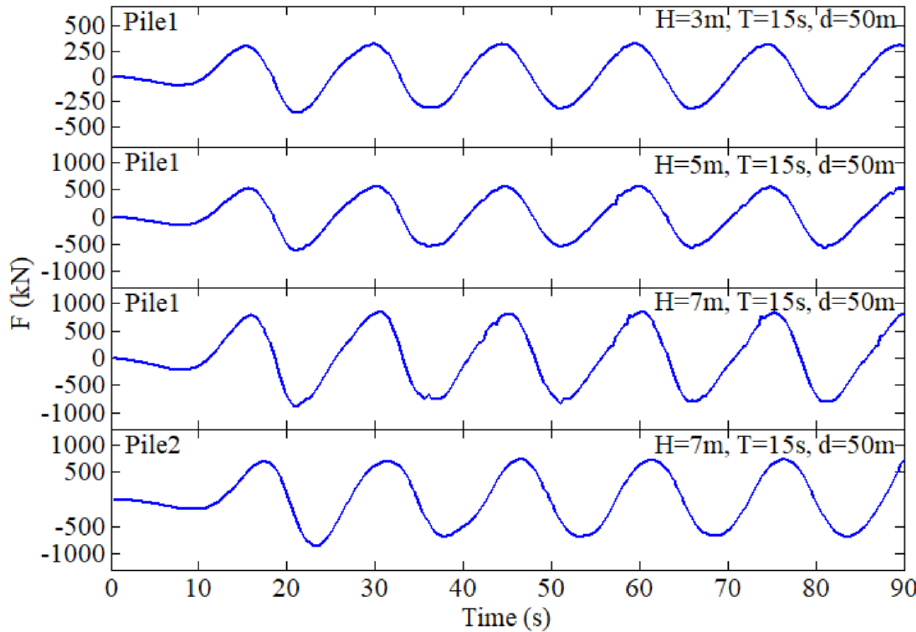
Figure 10. Time history of the wave-induced resultant force on the No. 1 and No. 2 pile legs of the jack-up platform under different wave